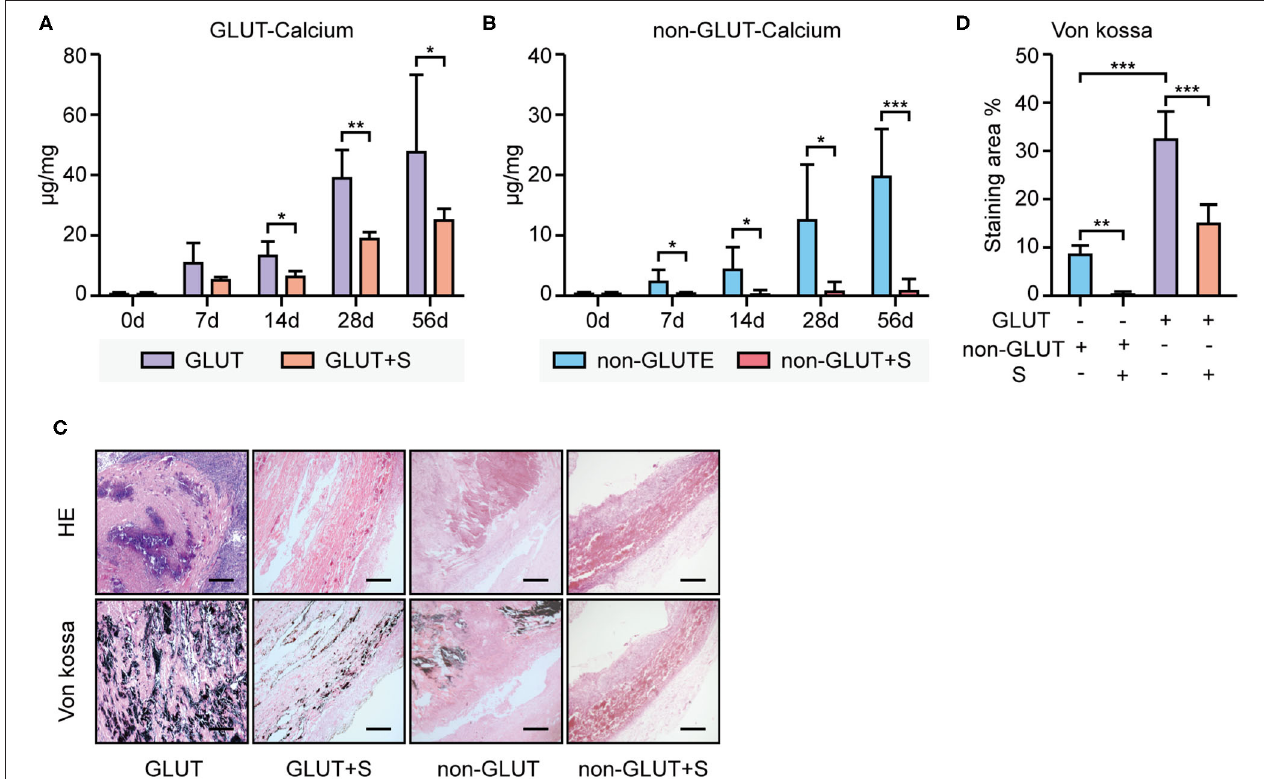
FIGURE 2 | Calcium deposition analysis of BHVs between the implant and implant + S group. (A) Calcium levels of GLUT BHVs between the implant and implant + S group, at days 0, 7, 14, 28, and 56 after implantation. (B) Calcium level of non-GLUT BHVs between the implant and implant + S groups at days 0, 7, 14, 28, and 56 after implantation. (C) Representative images and quantification of von Kossa staining and hematoxylin–eosin (HE) staining of BHVs in implant and implant + S groups 56 days after implantation; scale bars represent 400 µ m. (D) Quantification of von Kossa staining of BHVs in implant and implant + S groups 56 days after implantation. GLUT represents GLUT BHVs in the implant group, GLUT + S represents GLUT BHVs in the implant + S group, non-GLUT represents non-GLUT BHVs in the implant group, and non-GLUT + S represents non-GLUT BHVs in the implant + S group. N = 4–6, data are mean ± SD, * p < 0.05, ** p < 0.01, *** p <